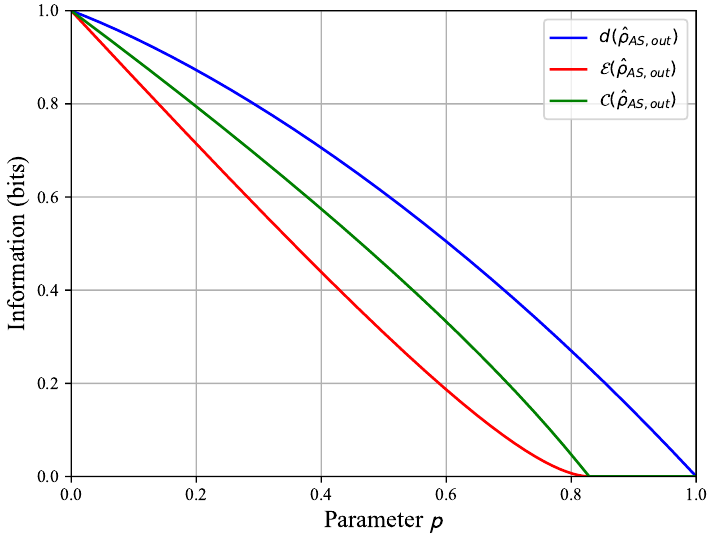
Figure 6. The entanglement rate E ( ˆ ρ AS,out ) (red), the concurrence of Wooters C ( ˆ ρ AS,out ) (green), and the quantum discord d ( ˆ ρ AS,out ) (blue) as functions of the parameter p for ξ = 1 / 2